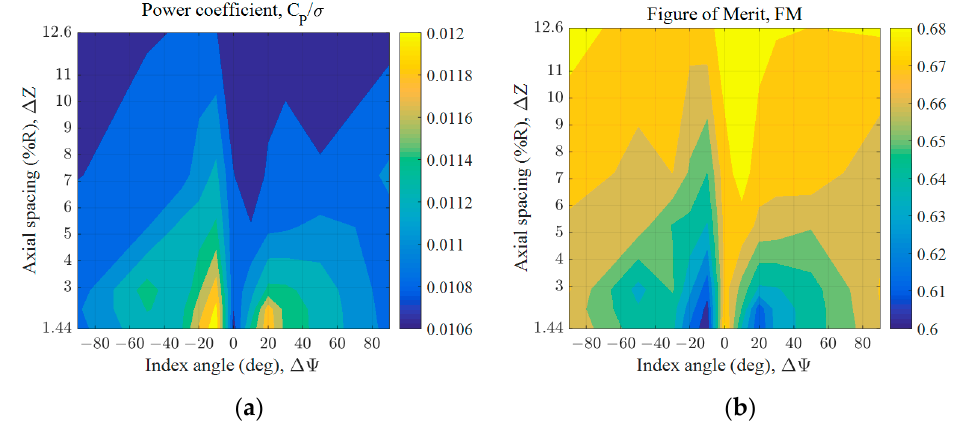
Figure 16. Section lift force (M 2 C l ) distributions at the axial spacing of 5.27%R ( C T = 0.0102): ( a ) Index angle = − 10°; ( b ) index angle = 10°.